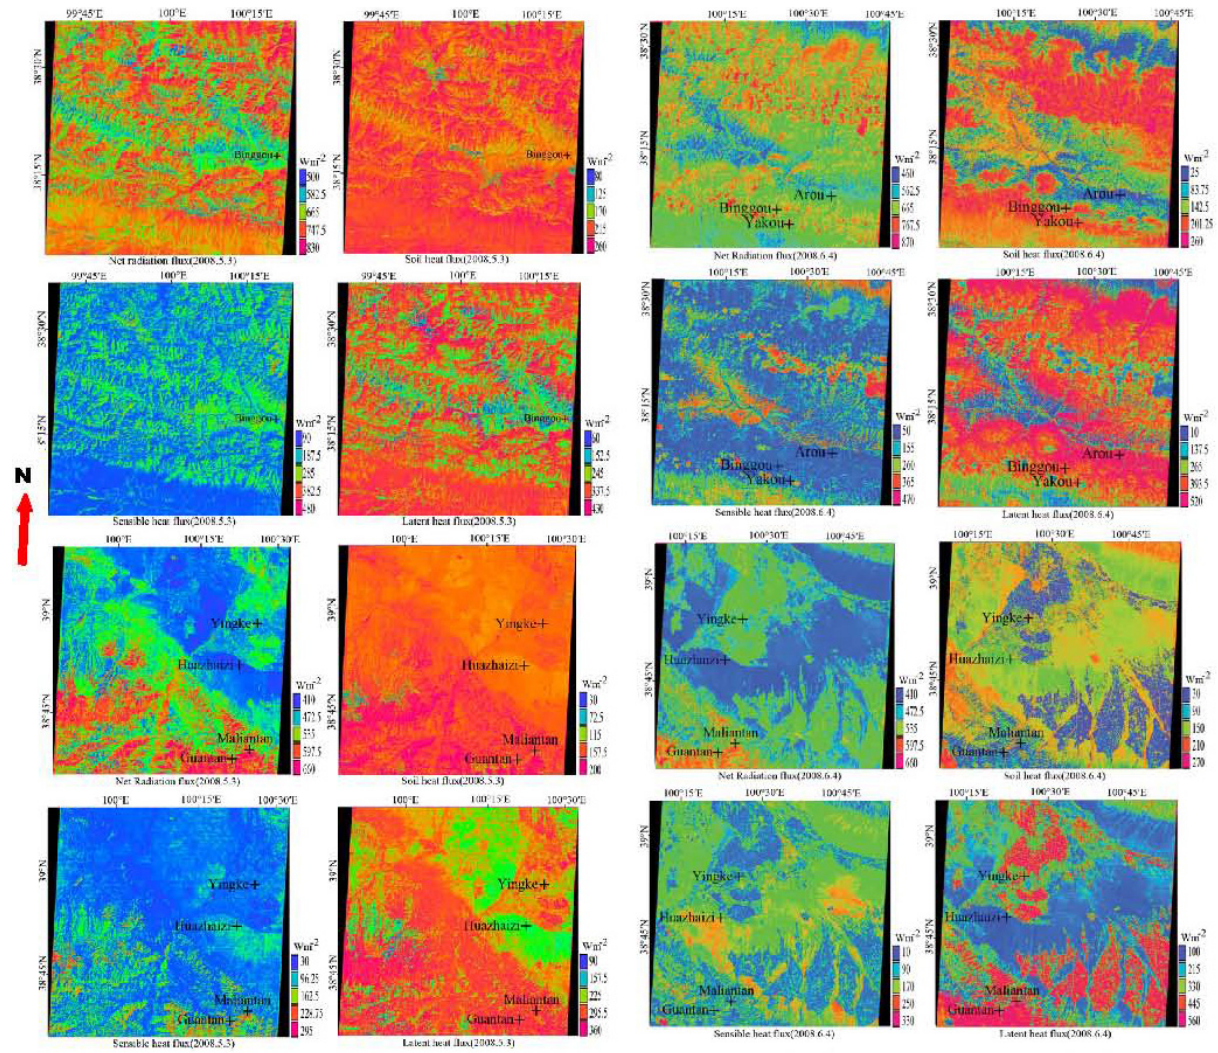
Fig. 4. Distribution maps of land surface heat fluxes over the WATER